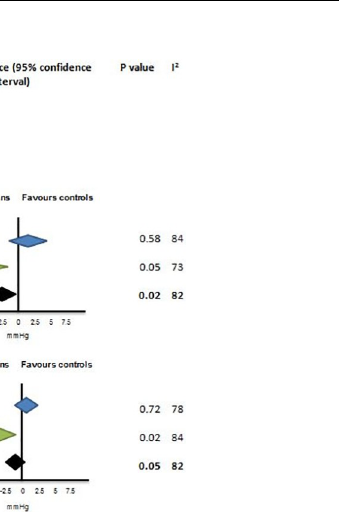
Fig 7. Systolic and diastolic blood pressure (mmHg) in vegans compared to omnivores.